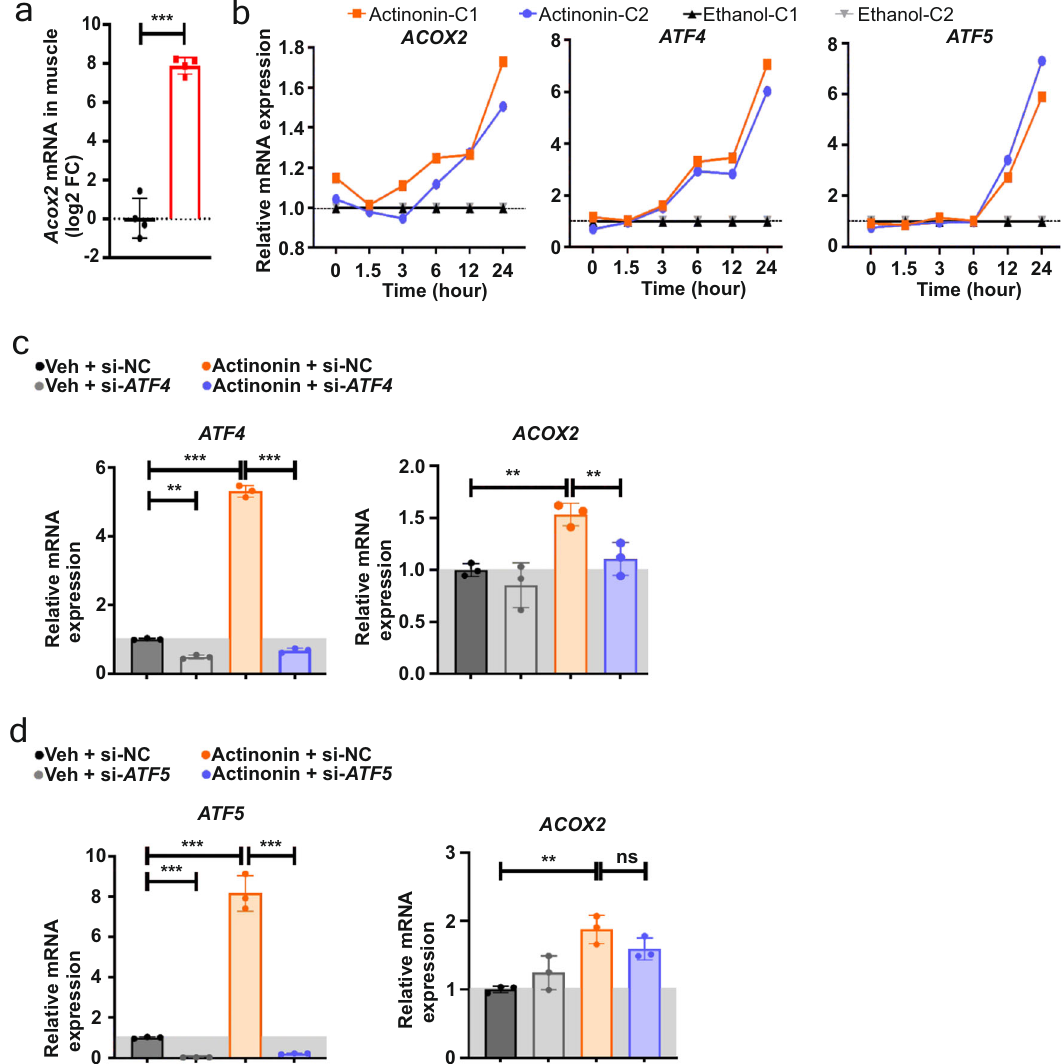
Fig. 4 ACOX2 is a peroxisomal marker for ISR. a Quanti fi cation of Acox2 mRNA expression in QF muscle of Grpel1 skm − / − mice ( n = 4 per genotype). b Timeline showing the induction of ACOX2 , ATF4 and ATF5 mRNA expression in human fi broblasts (C1 and C2 are independent control fi broblast lines) after treatment with actinonin, compared with vehicle (ethanol). c Quanti fi cation of ATF4 and ACOX2 mRNA expression after siRNA-mediated knockdown of ATF4 followed by 24 h of actinonin treatment ( n = 3 per treatment). d Quanti fi cation of ATF5 and ACOX2 mRNA expression after siRNA-mediated knockdown of ATF5 followed by 24 h of actinonin treatment ( n = 3 per Mitochondrial DNA copy number analysis . Total DNA was extracted from snap frozen QF muscle of control and Grpel1 skm − / − mice by phenol-chloroform extraction method and quanti fi ed using Spectrophotometer (DeNovix, DS-11 Series). 30 ng of isolated DNA was used as template. The mitochondrial DNA was quanti fi ed by amplifying the mitochondrial 12 S rRNA gene and normalized to nuclear RBM15 gene. Primers used were: 12S _Forward: AGGAGCCTGTT CTATAATCGATAAA, 12 S _Reverse: GATGGCGGTATATAGGCCGAA, RBM15 _Forward: GGACAGTTTTCTT GGGCAAC and RBM15 _Reverse: AGTTTGGCCCTGTGAGACAT. High-resolution respirometry . Total tissue lysates were used in Oroboros for respiration measurement. Tissue lysates in MiR05 (0.5 mM EGTA, 3mM MgCl 2 , 60mM K-lactobionate, 10mM KH 2 PO 4 , 20 mM HEPES, and 110 mM sucrose, pH 7.1) were taken to the chamber. We measured the response in oxygen fl ux for CI- coupled respiration after adding malate ( fi nal concentration 2mM), pyruvate (10 mM), glutamate (20mM), ADP (5 mM), and cytochrome C subsequently into the chamber. The CI + CII coupled respiration was measured with the addition of succinate (10 mM). Subsequent addition of carbonylcyanide-4-(tri fl uoromethoxy)- phenylhydrazone (FCCP) (2mM) provided maximal respiration (CI + CII uncoupled respiration) of mitochondria. Basal respiration was measured by